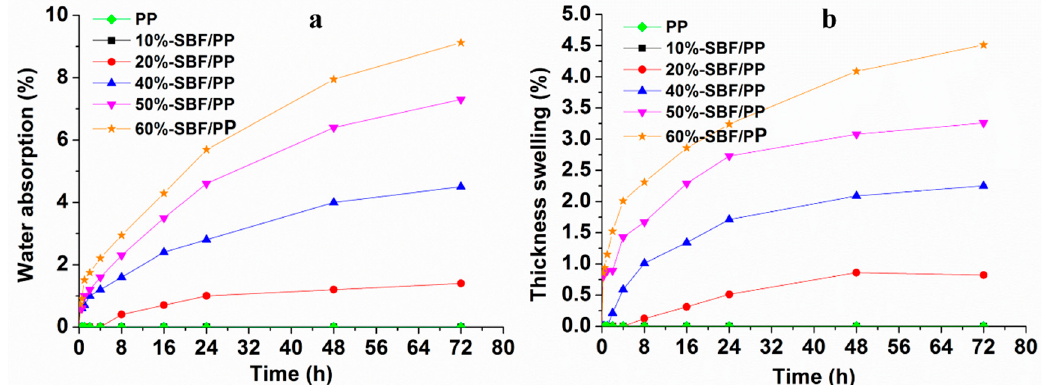
Figure 11. Water resistance of the pure PP and composites with different SBF contents. ( a ) waster absorption, ( b ) thickness swelling.